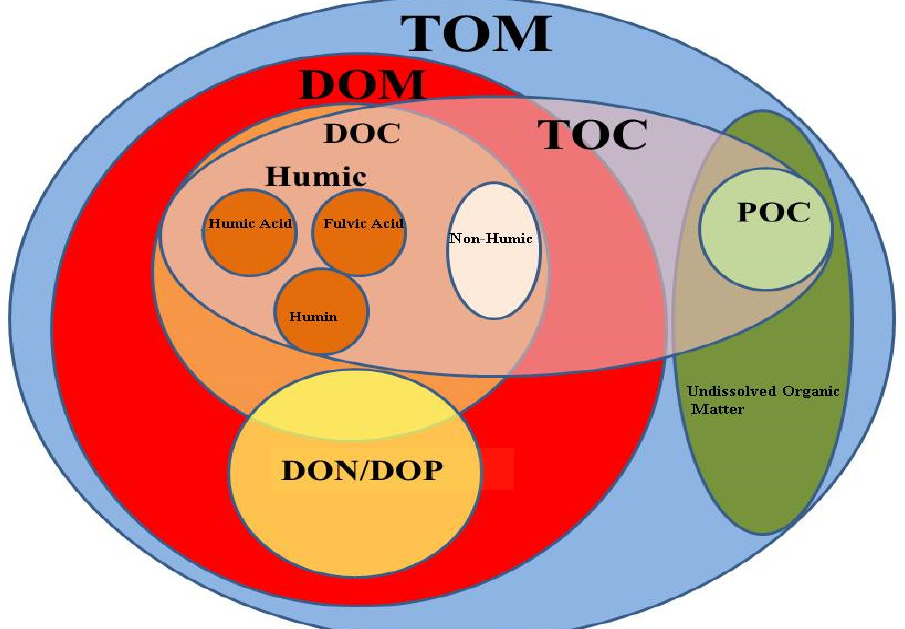
Figure 1. Simplified Venn representation of the various forms of organic matter found in natural waters. Total Organic Matter (TOM), Total Organic Carbon (TOC), Dissolved Organic Matter (DOM), Dissolved Organic Carbon (DOC), Particulate Organic Carbon (POC), Dissolved Organic Nitrogen (DON), and Dissolved Organic Phosphorus (DOP) are represented. DOC can be further broken down to its humic (humic acid, fulvic acid, and humin) and non-humic material, while new analytical methods continue to reveal more molecular-level